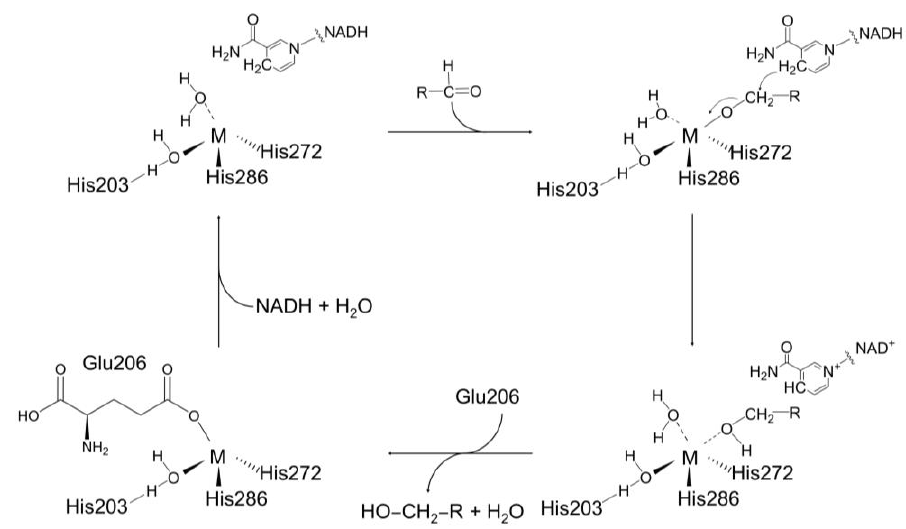
Figure 7. Proposed mechanism of BDH activity of FnYqdH. A tentative reaction mechanism involves extended proton relay systems.